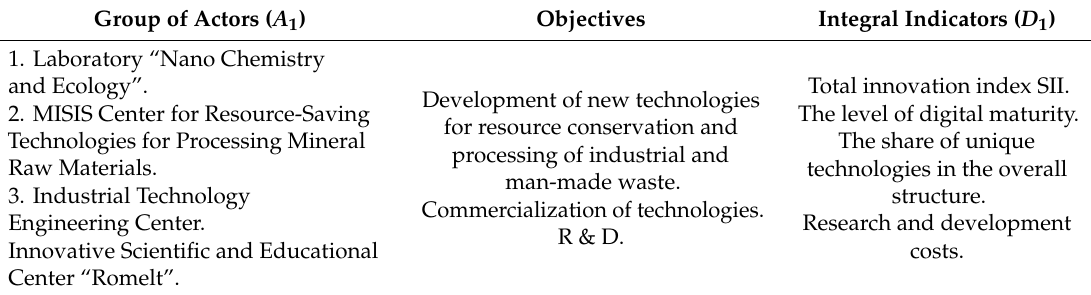
Table 2. Characteristics of actors—researchers (National University of Science and Technology (NUST) “MISIS”).